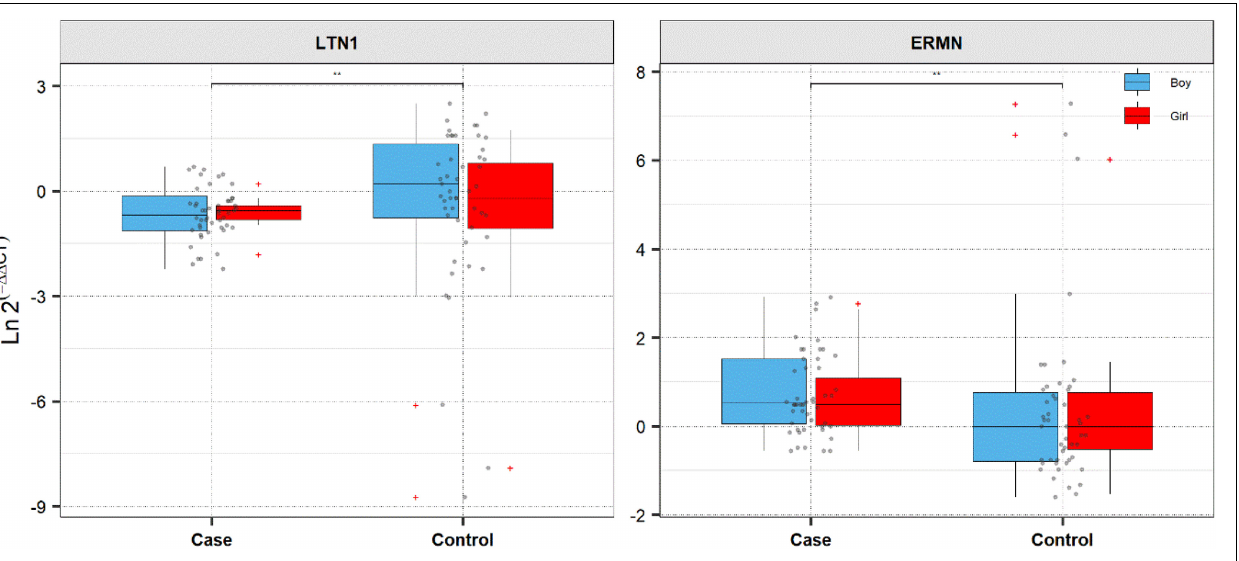
Frontiers in Molecular Neuroscience |